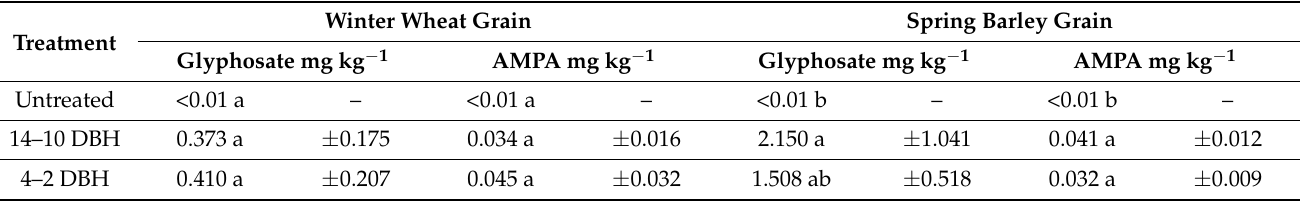
Table 1. Glyphosate and AMPA residues in harvested winter wheat and spring barley grain, applied